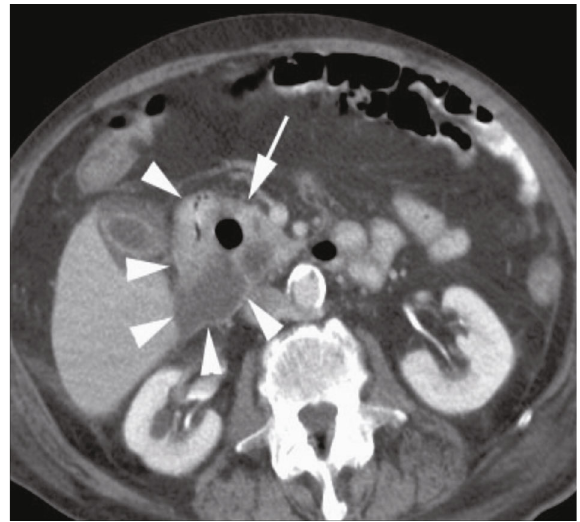
Figure 2: Duodenal diverticulitis with retroperitoneal perforation: (a) coronal CT scans at admission, (b) after 8 days of conservative treatment, and (c) after six weeks. The retroperitoneal air slowly resolves while the in fl amed duodenal diverticulum (arrow) regains its normal